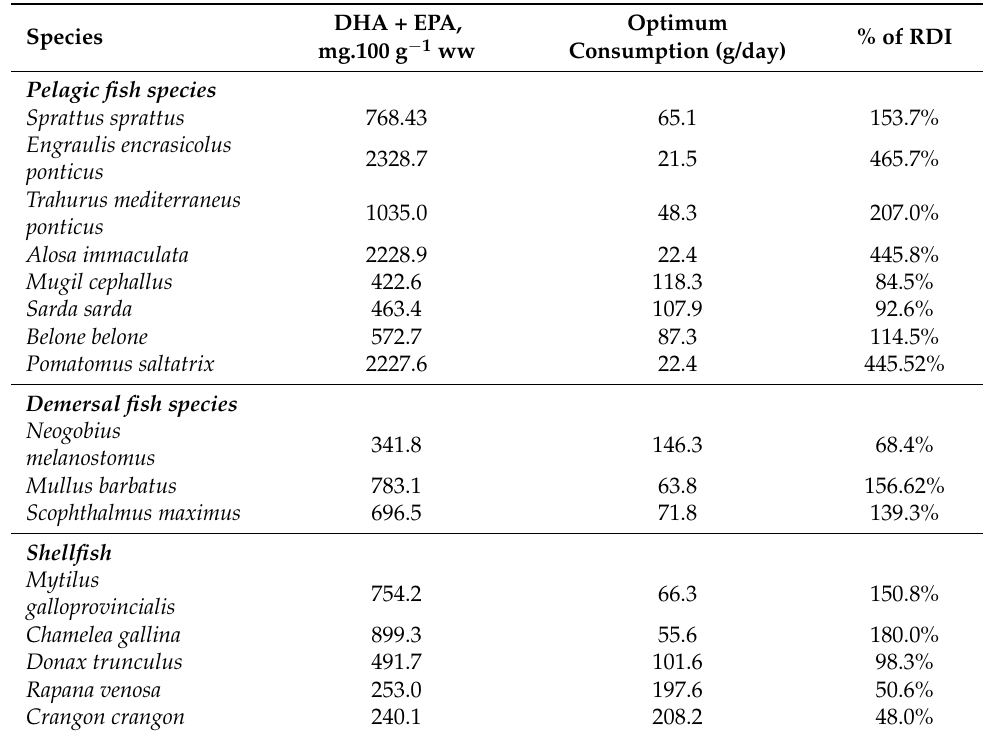
Table 6. Recommended daily serving (500 mg EPA + DHA per day) for Black Sea fish and